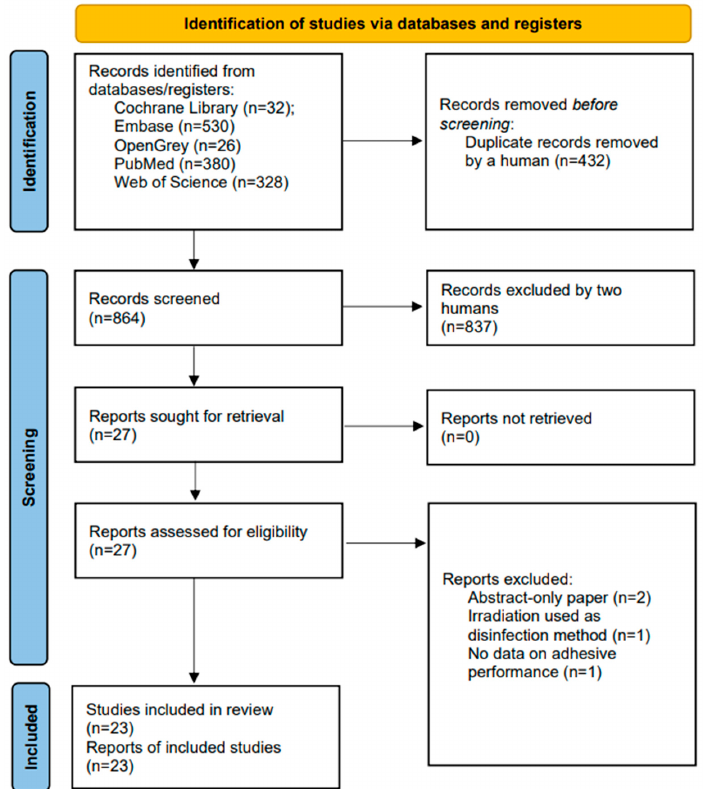
Figure 1. PRISMA 2020 flow diagram depicting the selection of records for this systematic review